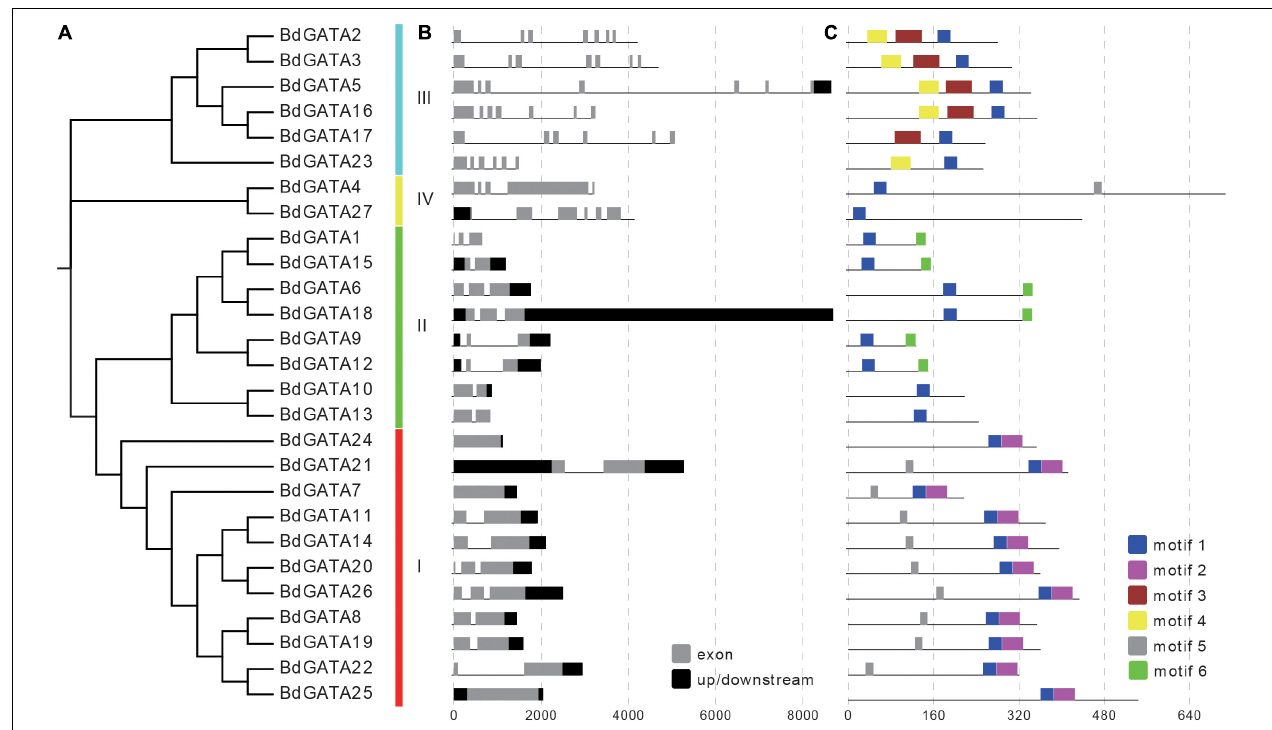
FIGURE 3 | Phylogenetic, gene structure, and conserved motif analysis of BdGATAs . (A) The phylogenetic tree divided GATAs into four subgroups. (B) Structures of BdGATA genes. Black rectangles indicate up/down stream sequences; gray rectangles indicate exons; gray lines indicate introns. (C) Conserved motif analysis of BdGATAs. Different motifs are identified and displayed in different